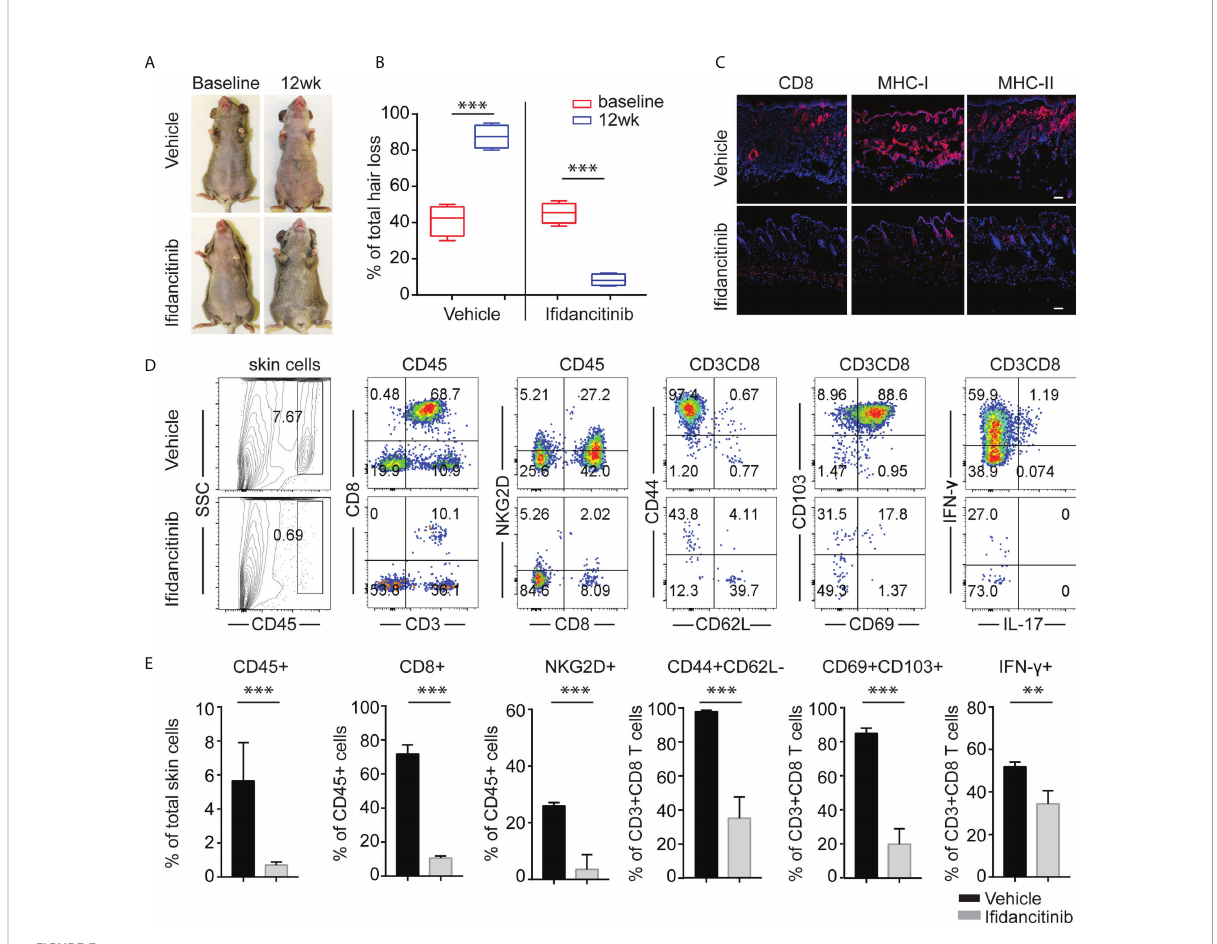
FIGURE 3 Reversal of established AA with I fi dancitinib treatment. C3H/HeJ mice with AA were given either I fi dancitinib (n=5) or vehicle control (n=5) in chow diets for 12 wks. (A) Representative images of I fi dancitinib or control treated C3H/HeJ mice before or after 12 weeks treatment. (B) Percentage of skin hair loss or regrowth is shown before and after treatment. ***P < 0.001 (Unpaired Student t test). (C) Representative immuno fl uorescence images of skin sections stained with anti-CD8, anti-MHC-I, or anti-MHC-II mAbs. Dashed scale bars represent 100 µm. (D) and (E) Representative FACS plots of cell suspension of mouse skin and the frequencies of in fi ltrating CD45 + leukocytes, IFN- g -producing CD8 + NKG2D + T cells and T cell differentiation and activation markers in skin of I fi dancitinib treated mice and control mice. **P < 0.01, ***P < 0.001 (Unpaired Student t